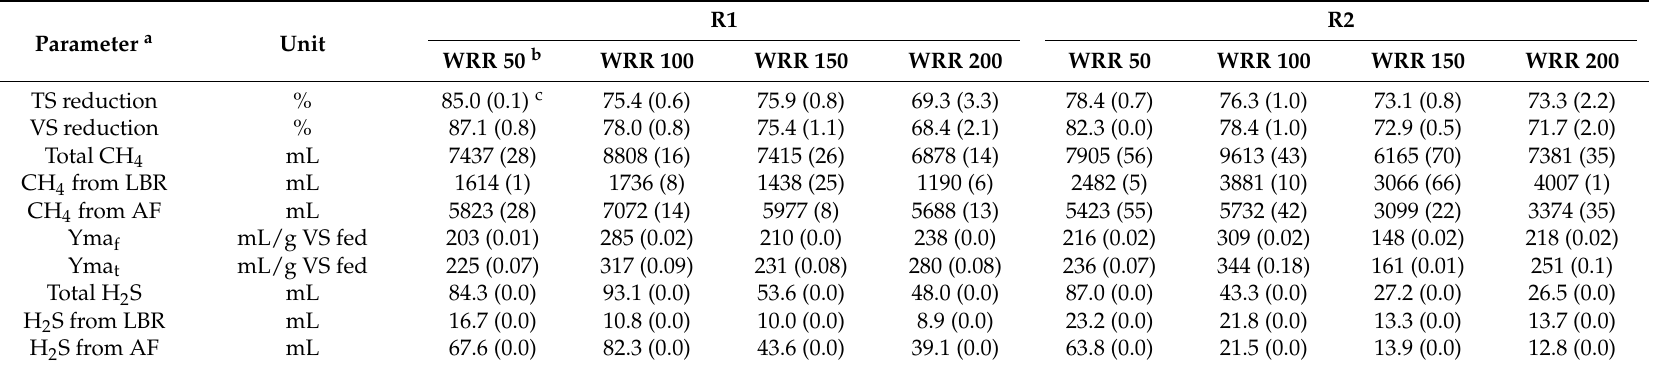
Table 2. Performance of the experimental reactors at different water replacement